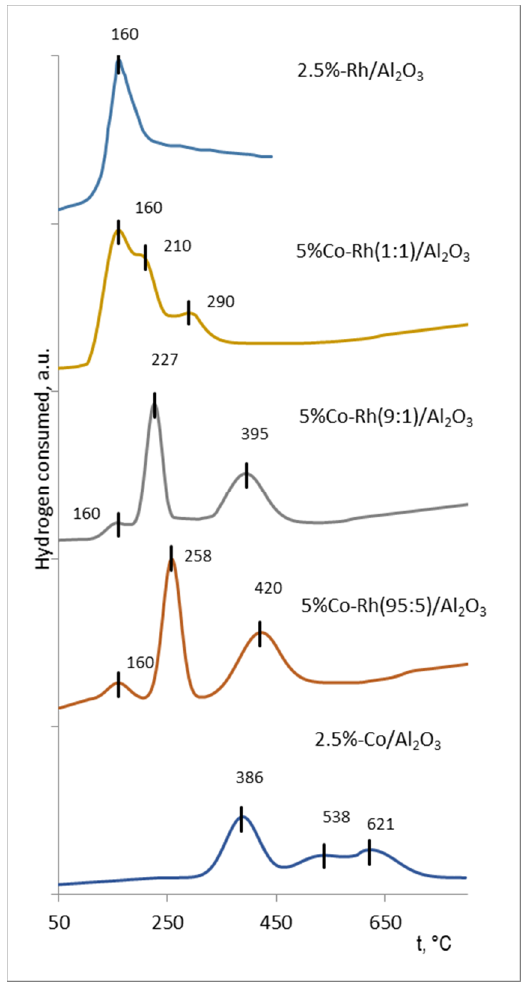
Figure 5. H 2 -TPR profiles of the mono- and bimetallic Co-Rh/Al 2 O 3 catalysts. There is one peak at 160 °C for monometallic Rh/Al 2 O 3 catalyst corresponding to